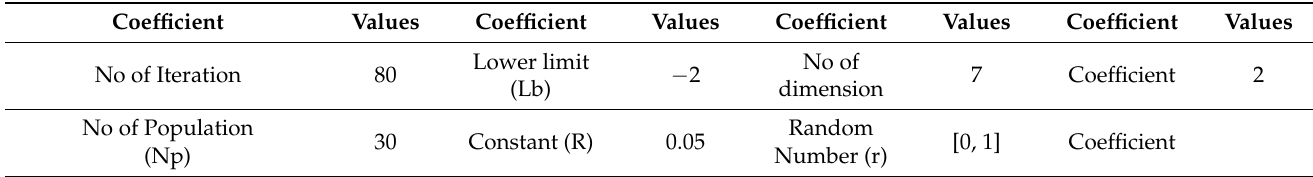
Table A2. DTBO Coefficient and Their